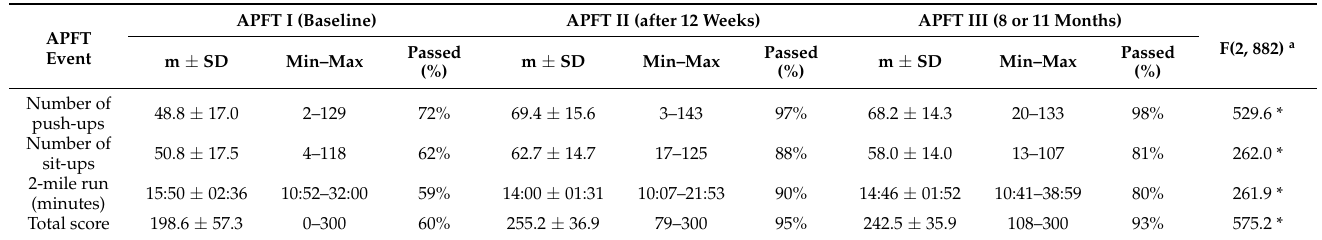
Table 1. The average results of conscripts’ (n = 883) APFT events and the overall score; the proportion of conscripts that passed the test in each measurement time.